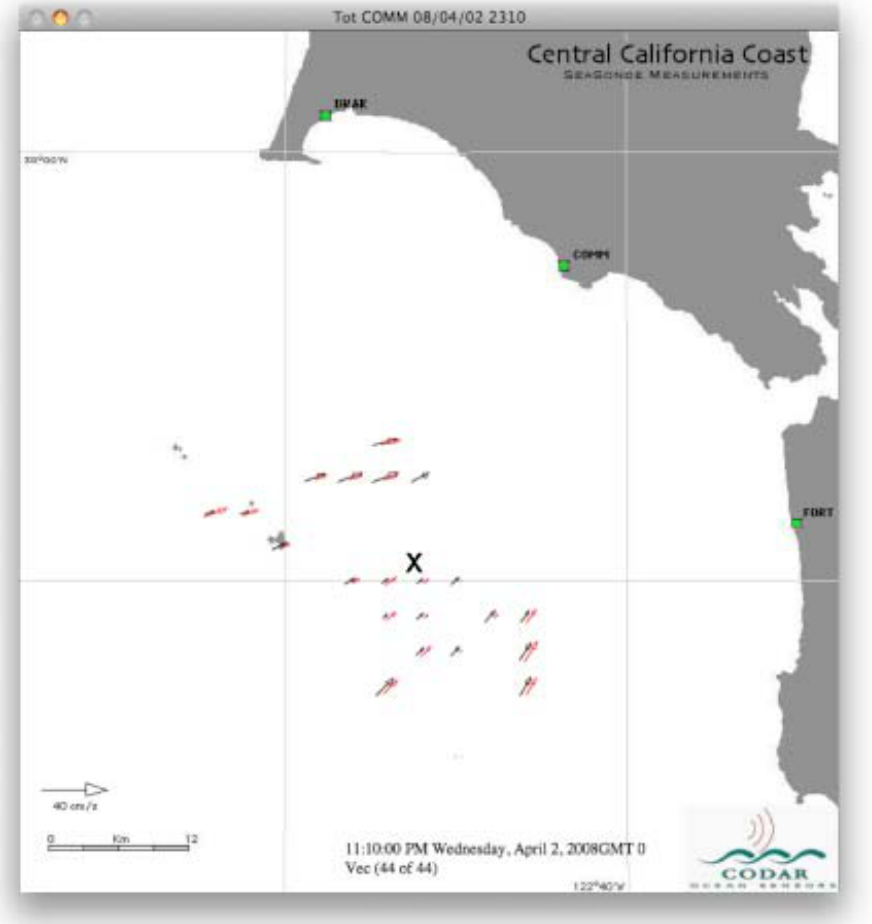
Figure 18. Elliptical velocity comparison map. Black—elliptical component of total velocity vectors from COMM, FORT. Red—measured by COMM. Time series of elliptical velocities at the point shown marked X are plotted in Figure